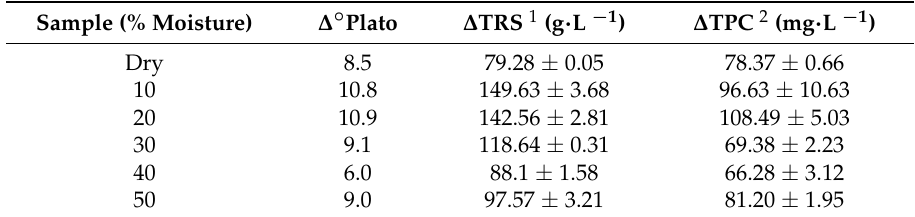
Table 3. Variation ( ∆ ) between parameters before (soluble fraction) and after mashing (sweet wort) calculated by simple